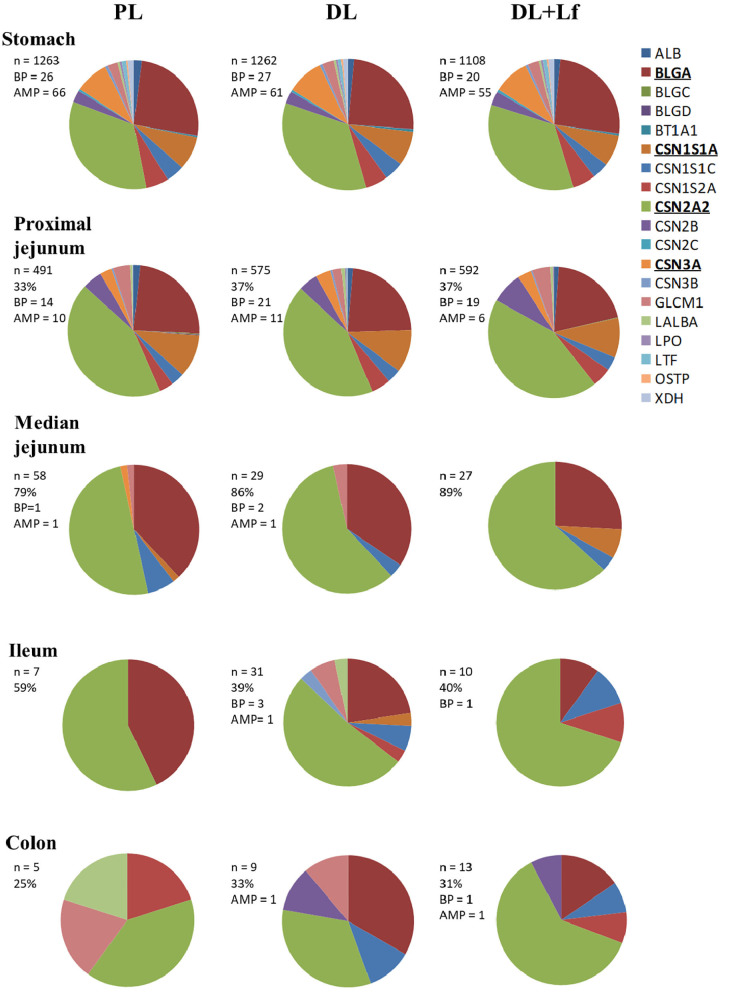
Pie chart distributions of peptides by parent proteins throughout the gastrointestinal tract. Proteins that appear in bold and underlined are the main parent proteins. In the insert, the following information are given: n, number of peptides; %, % of peptides common with the preceding compartment; BP, bioactive peptides; AMP, predicted anti-microbial peptides. Formulas contained as lipids either only plant lipids (PL, n = 5–8), a half-half mixture of plant and dairy lipids (DL, n = 5–8), or a half-half mixture of plant and dairy lipids supplemented with Lf (DL+Lf, n = 6–7). ALB, serum albumin; BLGA, β-lactoglobulin A; BLGC, β-lactoglobulin C; BLGD, β-lactoglobulin D; BT1A1, butyrophilin; CSN1S1A, casein α-S1 A; CSN1S1C, casein α-S1 C; CSN1S2A, casein α-S2 A; CSN2A2, β-casein A2; CSN2B, β-casein B; CSN2C, β-casein C; CSN3A, κ-casein A; CSN3B, κ-casein B; GLCM1, glycosylation-dependent cell adhesion molecule; LALBA, α-lactalbumin; LPO, lactoperoxydase; LTF, lactoferrin; OSTP, osteopontin; XDH, xanthine dehydrogenase/oxidase.